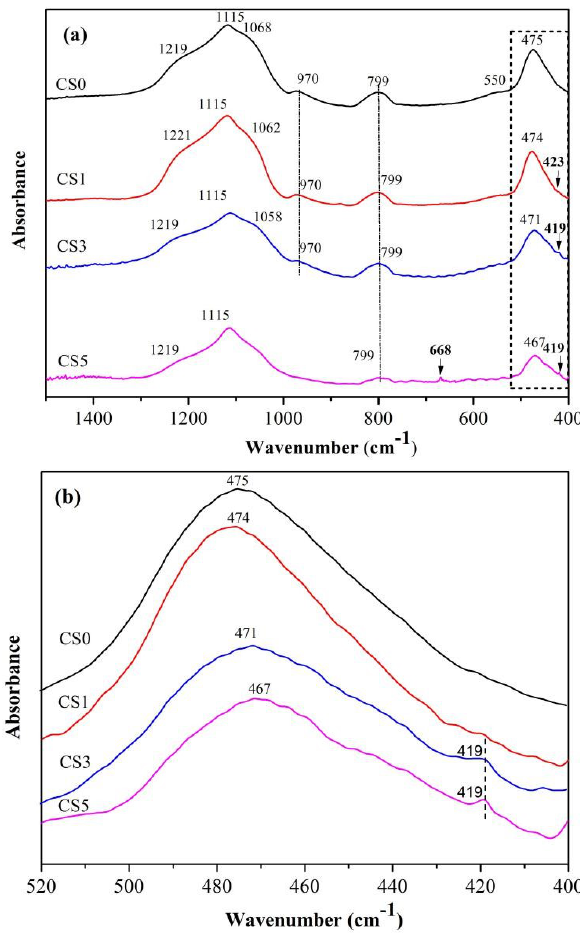
Figure 5: FTIR spectra of colloidal silica without and with 0.1–0.5 wt.% MgO after curing for 24 hours at 30 ∘ C (a), and the magnifica- tion of FTIR spectra in the 520–400 cm −1 region